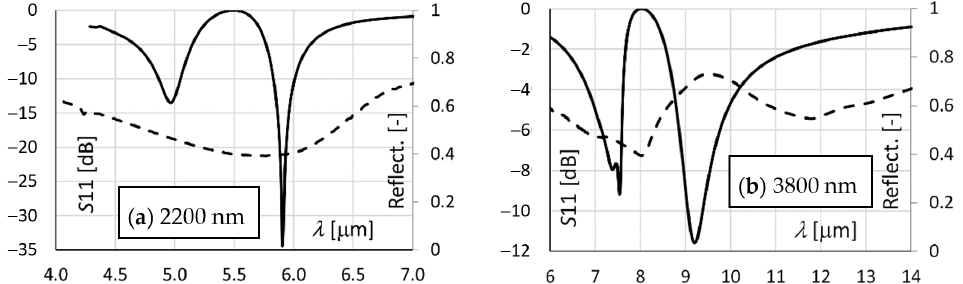
Figure 9. Comparison of the spectral characteristics of the simulated scattering parameter S11 (full line) and the measured reflectance (dashed line) of dipoles with lengths of 2200 nm ( a ) and 3800 nm ( b ).